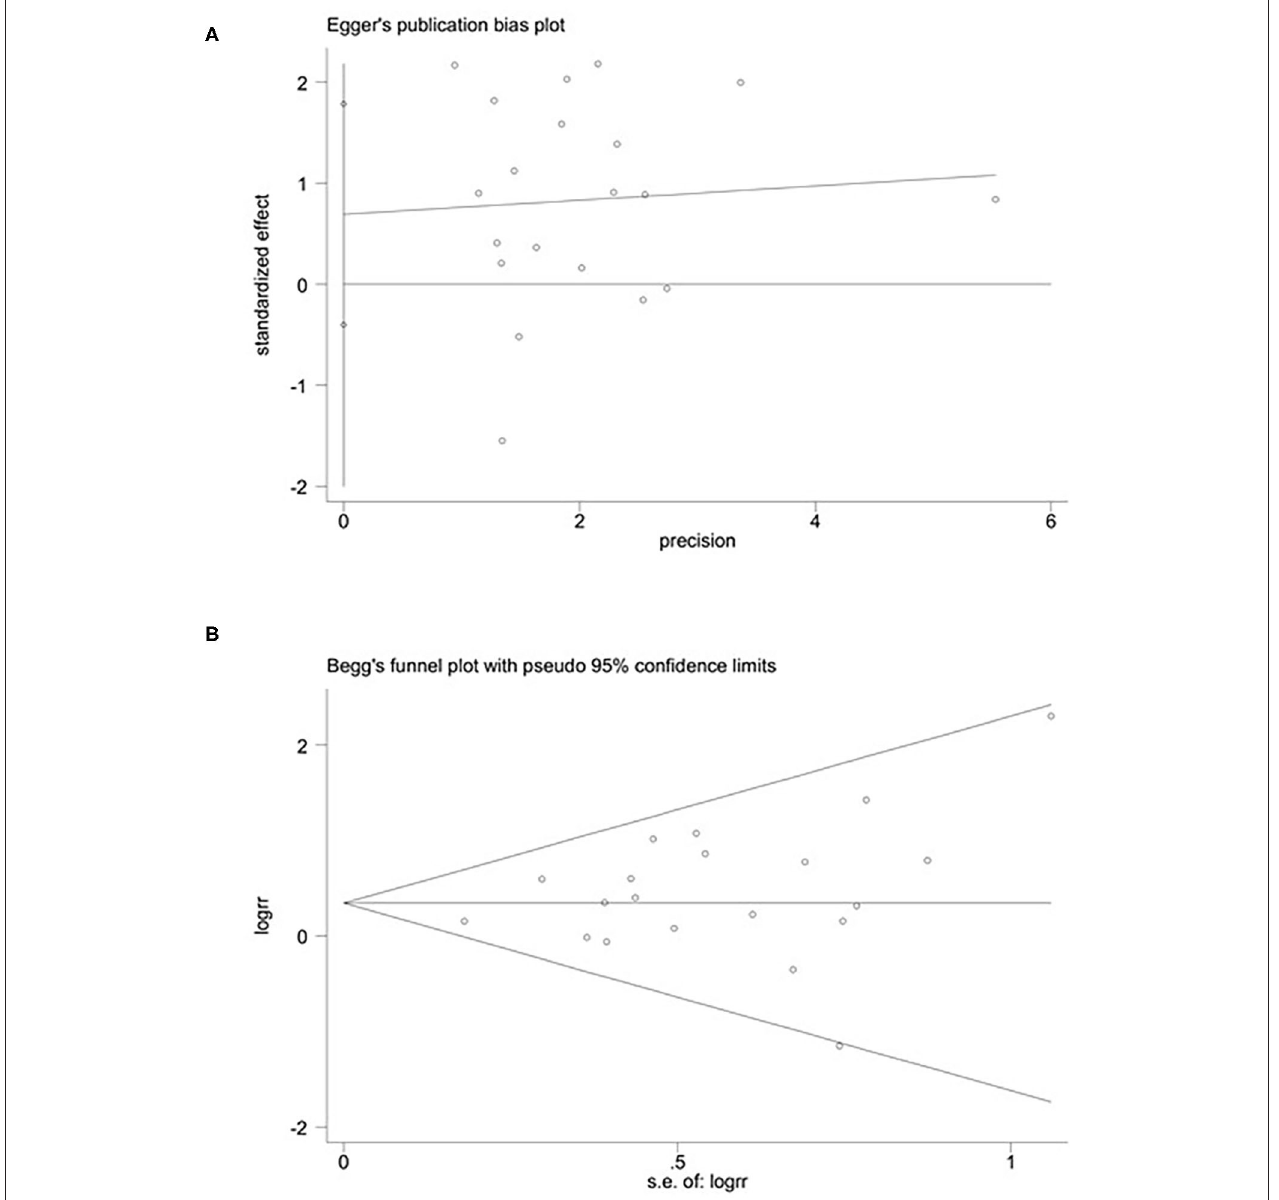
FIGURE 2 | Publication bias: Begg’s (A) ( p > 0.05) and Egger’s (B) ( p > 0.05) funnel plots for possible publication bias in the current study. No publication bias was found, indicating credible